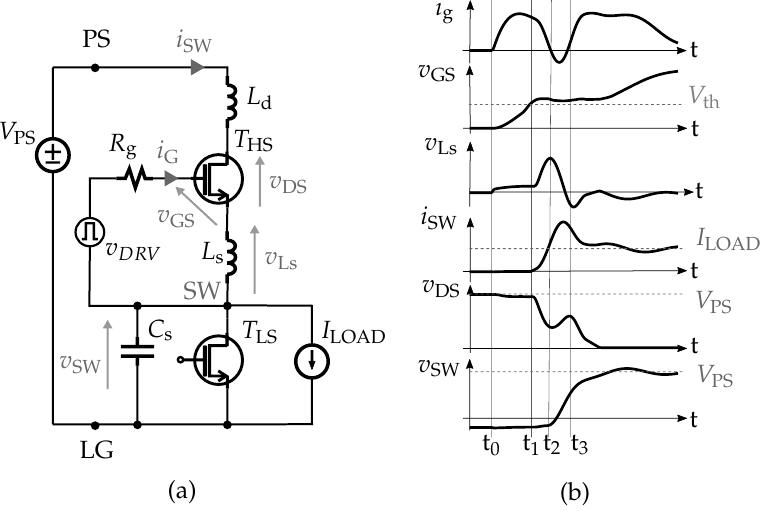
Figure 6. ( a ) Simplified model of a single leg for the analysis of the turn-on when the high-side transistor is driven by a convention gate driver and the source inductance is considered, and ( b ) the corresponding switching